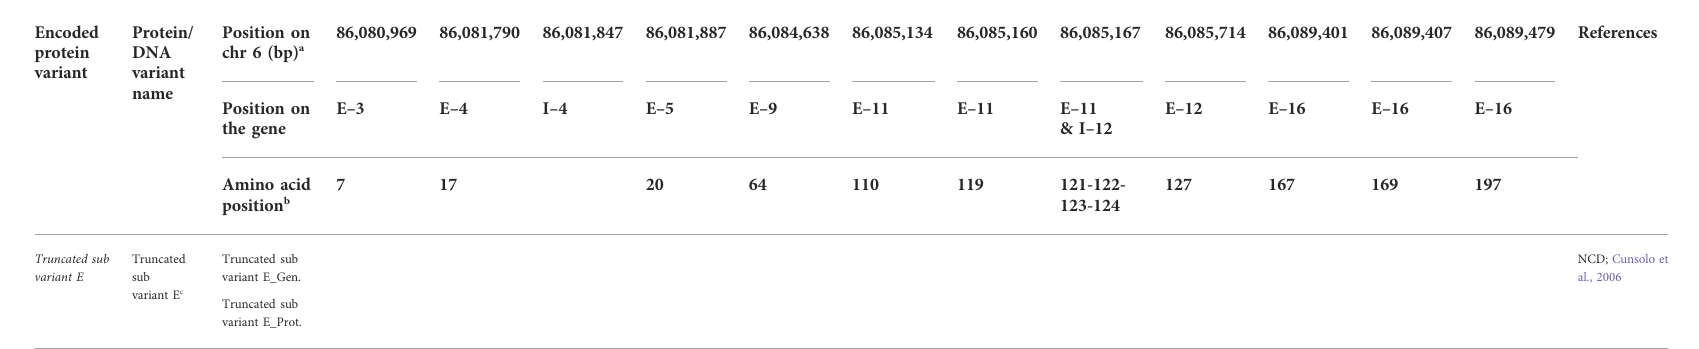
TABLE 2 ( Continued ) Nucleotide and amino acid variants within the gene and mature protein of the CSN1S2